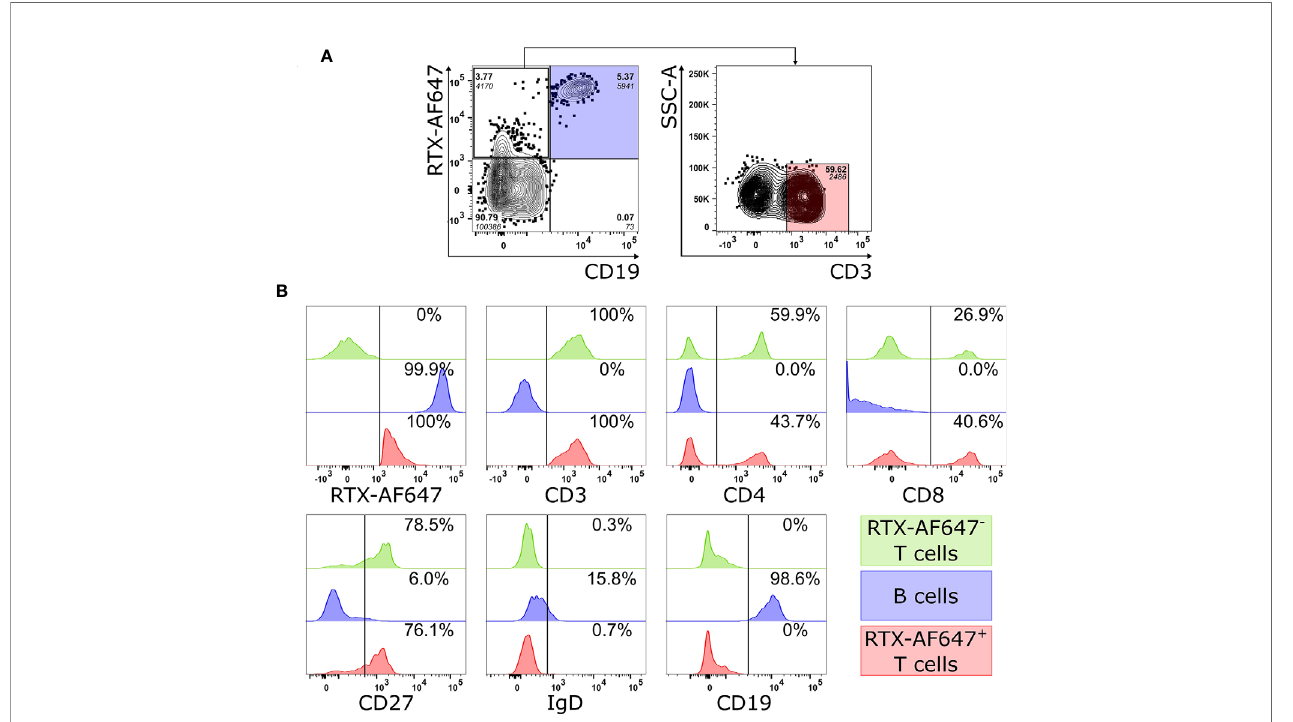
FIGURE 2 | (A) FACS analysis of PBMC from a healthy donor gated on CD45 + lymphocytes (left panel) shows a population of CD19 − RTX-AF647 + cells, 59.6% of which expresses the T cell marker CD3 (right panel). (B) The expression patterns of RTX-AF647, CD3, CD4, CD8, CD27, CD19, and IgD were assessed in equal counts of CD19 + B cells (blue), RTX-AF647 + CD3 + cells (RTX-AF647 + T cells, red), and RTX-AF647 − CD3 + cells (RTX-AF647 − T cells, green). RTX-AF647 + T cells (red) express CD3, CD4, CD8, and CD27 at a similar fl uorescence intensity as RTX-AF647 − T cells (green) and lack the expression of the B cell markers CD19 and surface IgD. For gating strategy see supplemental data ( Figure S1 ). Event counts for each gate are indicated in italic below the frequency